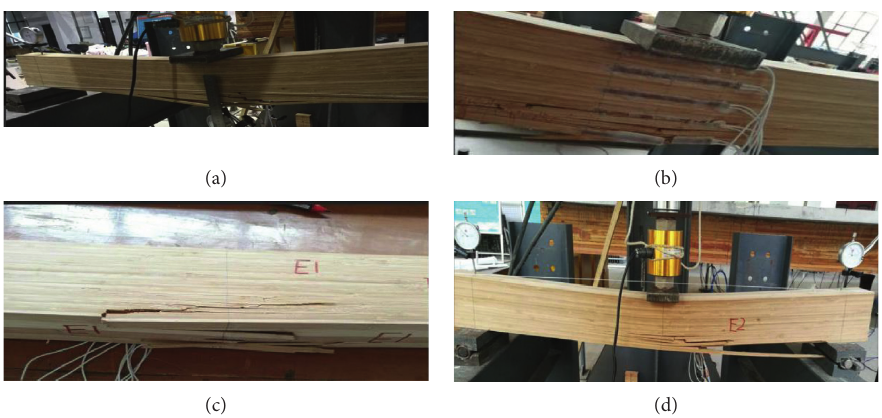
Figure 4: Failure modes of specimens. (a) Specimen D1. (b) Specimen D2. (c) Specimen E1. (d) Specimen